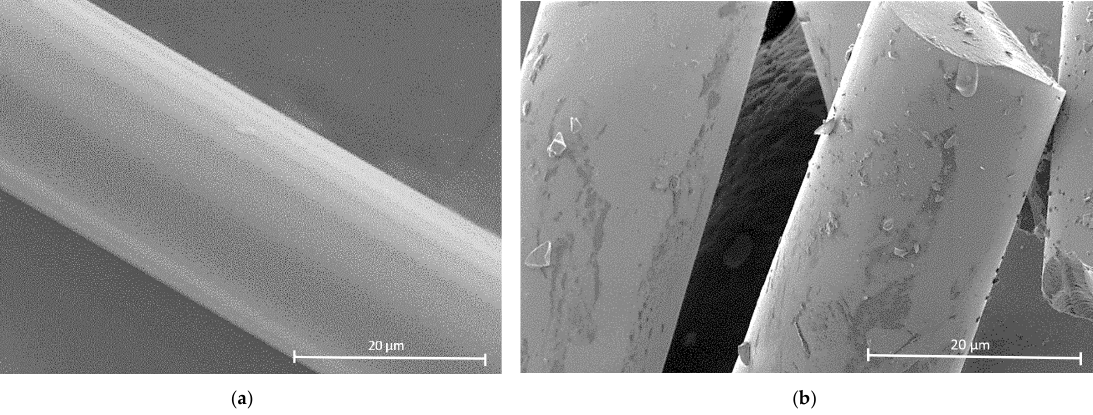
Figure 8. Morphology of PCS fibers before ( a ) and after ( b ) thermomechanical analysis at up to 400 °C.